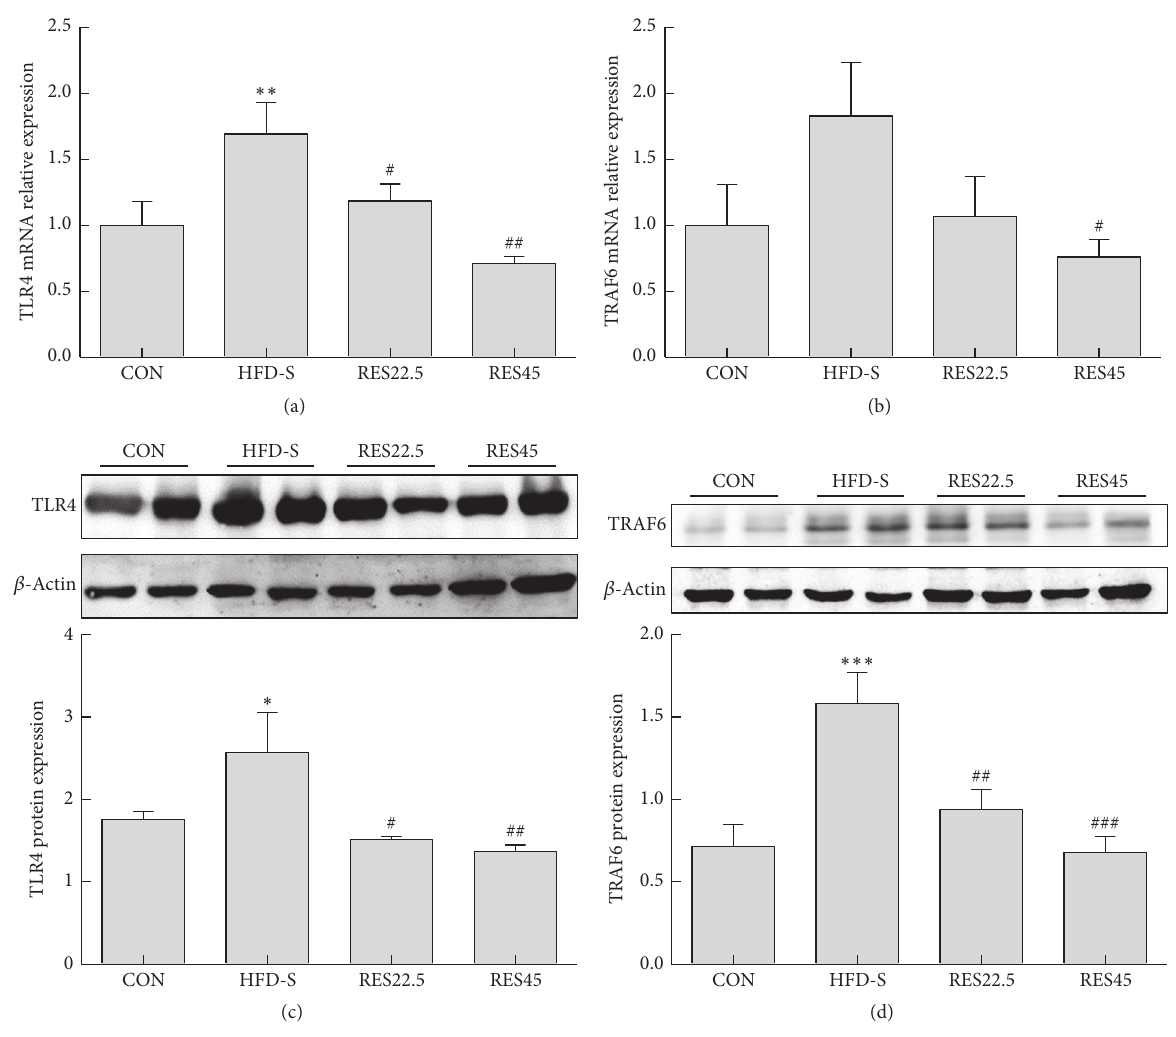
Figure 5: TLR4/TRAF6 mRNA and protein expression. The relative expression levels of TLR4 mRNA (a) and TRAF6 mRNA (b) were determined by real-time RT-PCR. Whole cell protein concentrations were determined and the relative amount of TLR4 (c) and TRAF6 (d) was assessed by Western blot analysis. 𝑛 = 5 mice per group. One-way ANOVA was used to test for statistical significance. Data were expressed as the mean ± SEM. ∗ 𝑃 < 0.05 , ∗∗ 𝑃 < 0.01 , and ∗∗∗ 𝑃 < 0.001 versus the CON group; # 𝑃 < 0.05 , ## 𝑃 < 0.01 , and ### 𝑃 < 0.001 versus the HFD-S